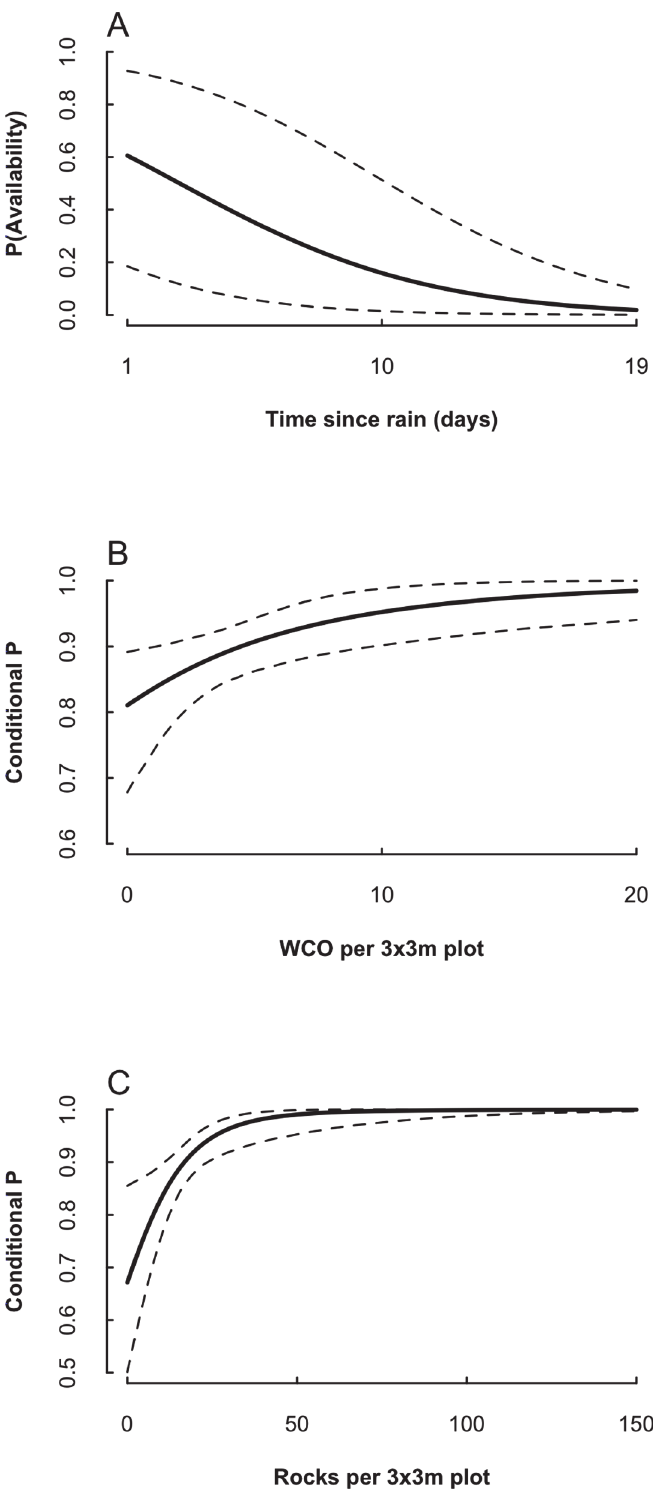
Fig 4. Relationships between availability probability (A), conditional detection probability (B, C), and important salamander survey covariates. Predicted using model TE[season]; dashed lines indicate 95%